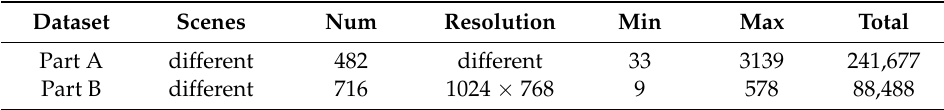
Table 1. ShanghaiTech dataset. Num is the number of images; Max is the maximum crowd count; Min is the minimal crowd count; Total is total number of labeled